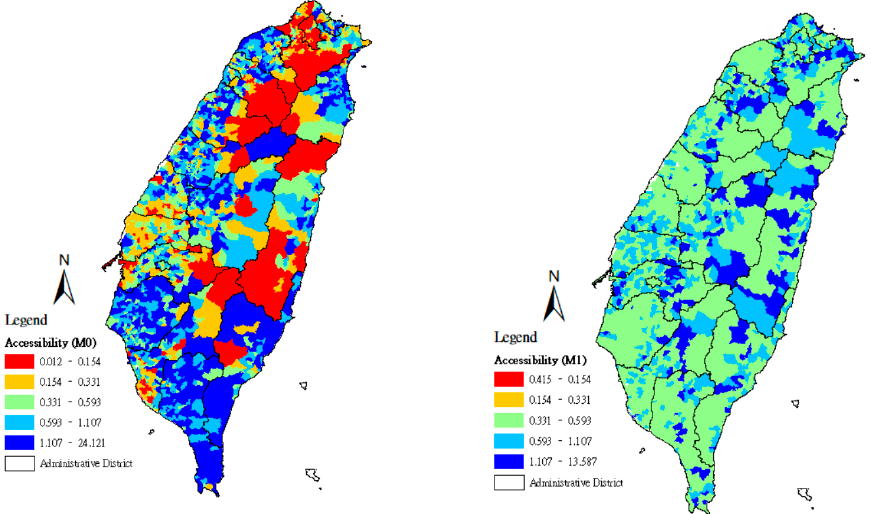
Figure 1. Accessibility score of community care resources in Taiwan using methods M0 and M1.